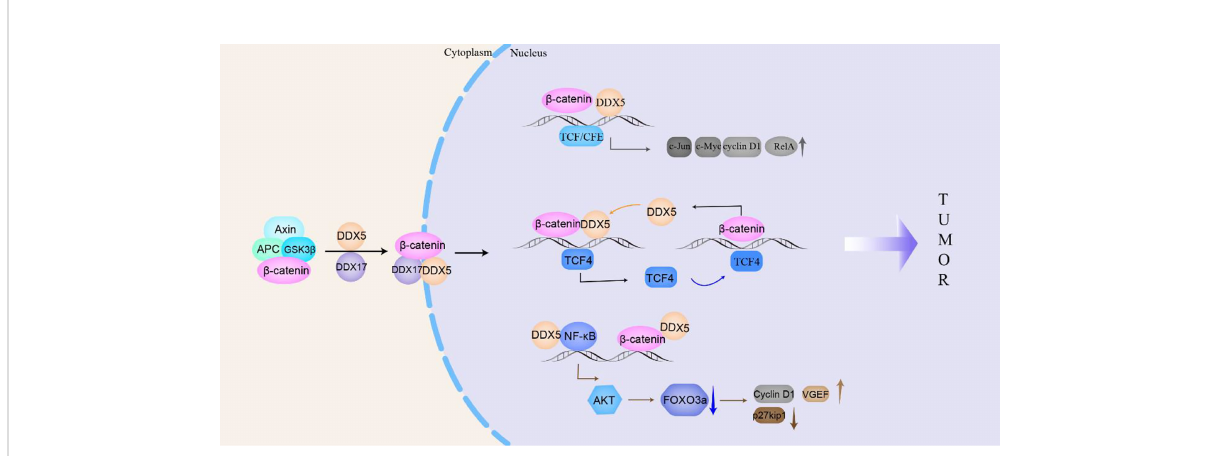
FIGURE 4 DDX5/DDX17 participate in the b -catenin signaling pathway to promote tumorigenesis and tumor progression. In the cytoplasm, DDX5/DDX17 dissociate b -catenin from the complex and transport it to the nucleus to promote the transcription of b -catenin target genes ( c-Jun , c-Myc , cyclin D1 , TCF4 , AKT , etc.), which then participate in tumorigenesis and tumor